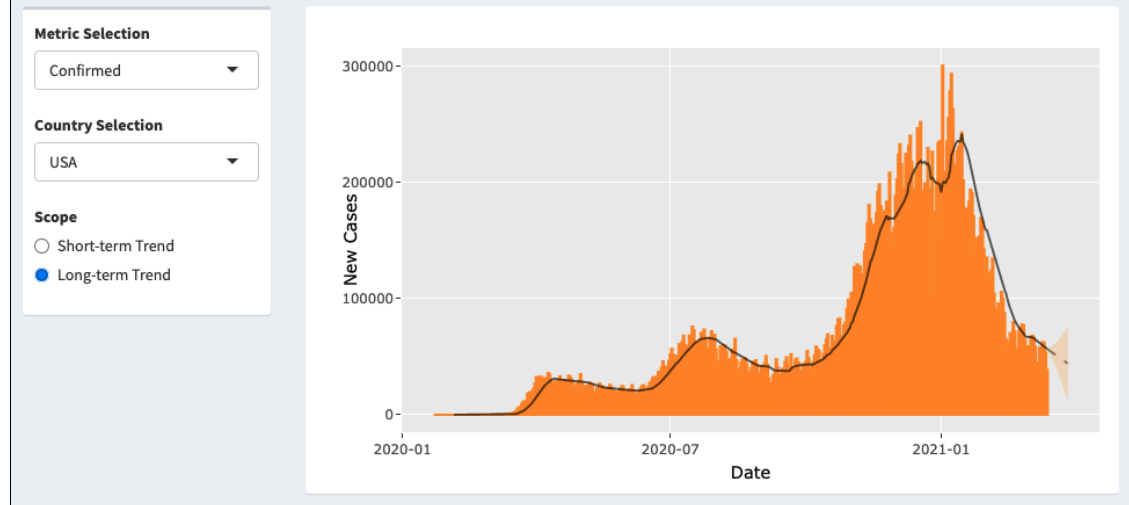
Figure 10. New Confirmed Cases Long-term Trend in